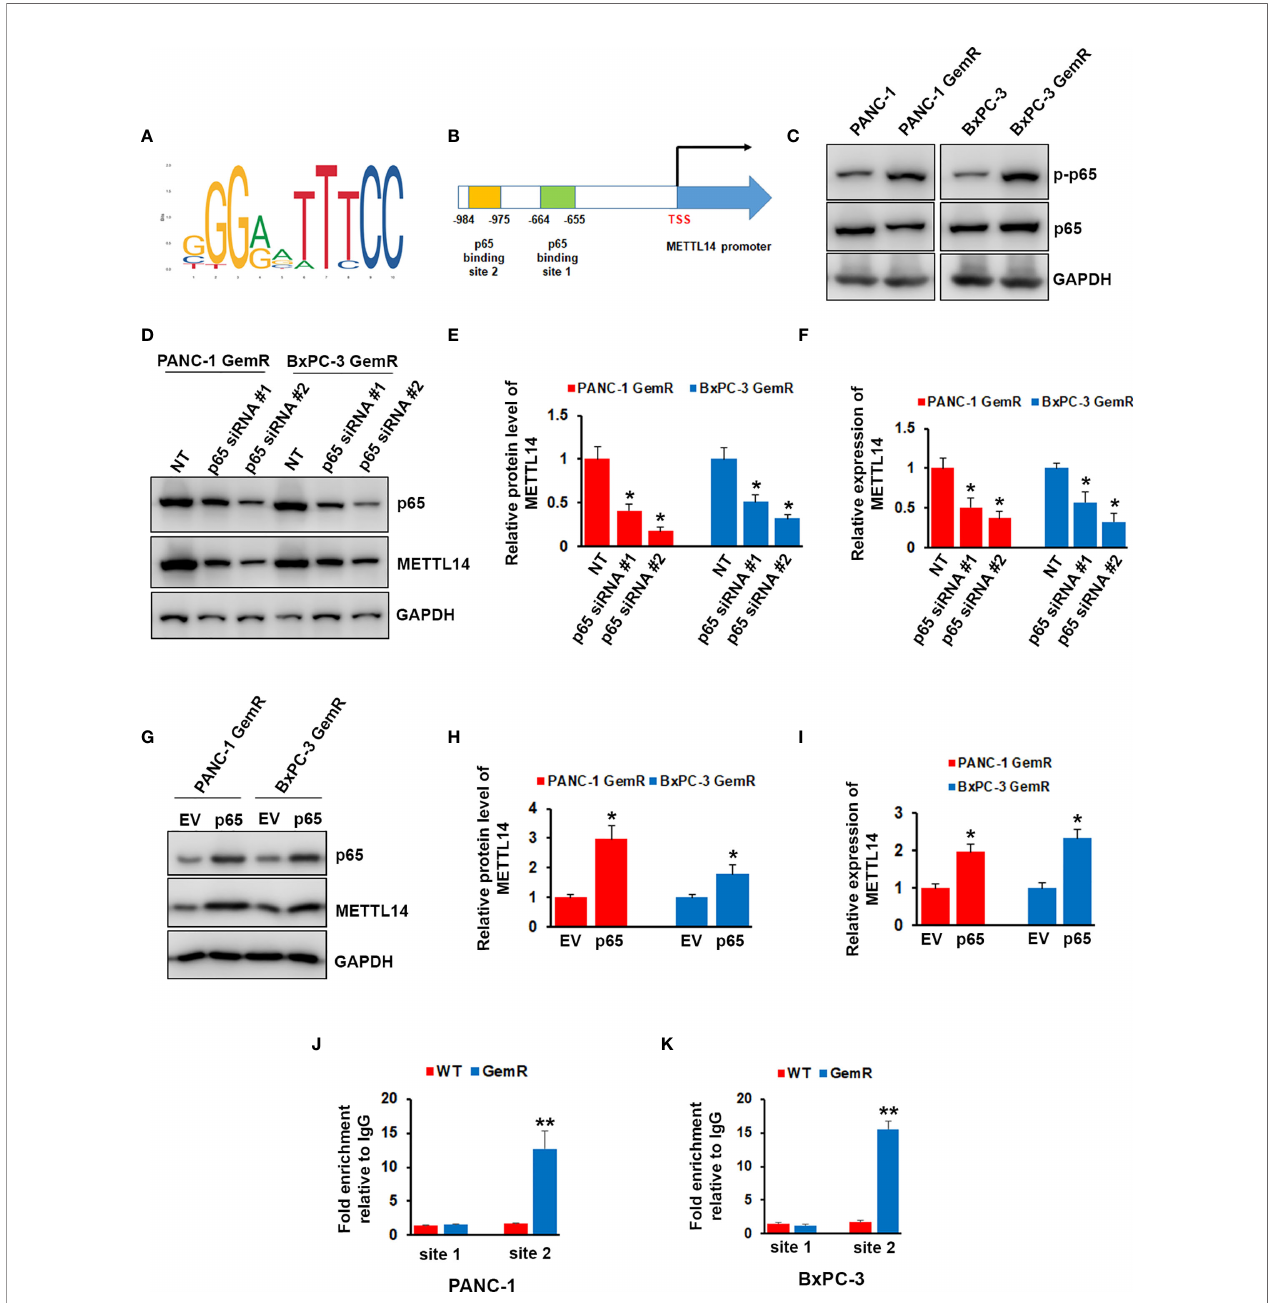
FIGURE 4 | Effect of p65 on regulating METTL14 expression. (A) The canonical binding motif of p65. (B) Schematic diagram of METTL14 promoter region containing two putative p65 binding sites. (C) The phosphorylation of p65 and total p65 levels in PANC-1 GemR/BxPC-3 GemR and their parental wild type cells was assessed by western blotting. (D – F) The protein (D, E) and mRNA (F) level of METTL14 was assessed by western blotting and QRT-PCR after p65 depletion. Data are reported as means ± SEM of values from three experiments. *p < 0.05. (G – I) The protein (G, H) and mRNA (I) level of METTL14 was assessed by western blotting and QRT-PCR after p65 overexpression. Data are reported as means ± SEM of values from three experiments. *p < 0.05. (J, K) ChIP assay indicated an increase in p65 binding to METTL14 promoter via binding site 2 in PANC-1 GemR/BxPC-3 GemR compared with their parental wild type cells. **p <